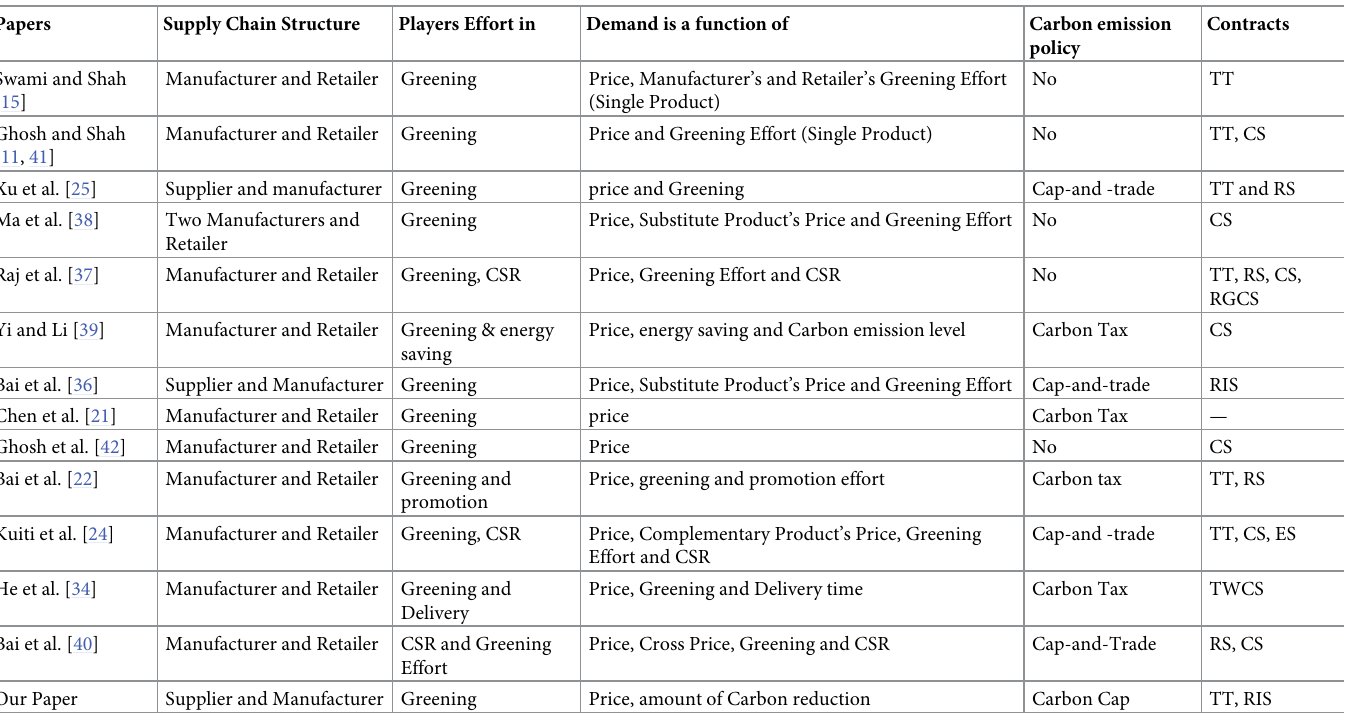
Table 1. Summary of literature